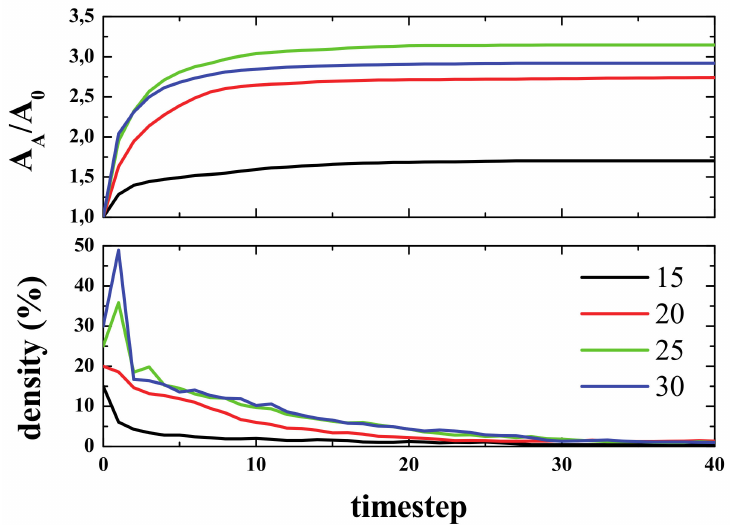
Figure 19. (Color online) Top panel: Activated area vs. time for different initial densities as labelled. Bottom panel: Density vs. time for different initial densities. Final density is approximately 0.9%. Second NN configuration, 69/789 rule